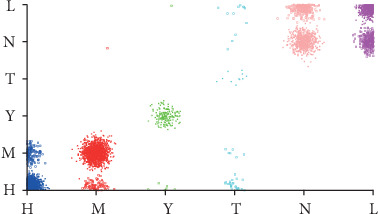
Illustration of errors of the random forest algorithm.